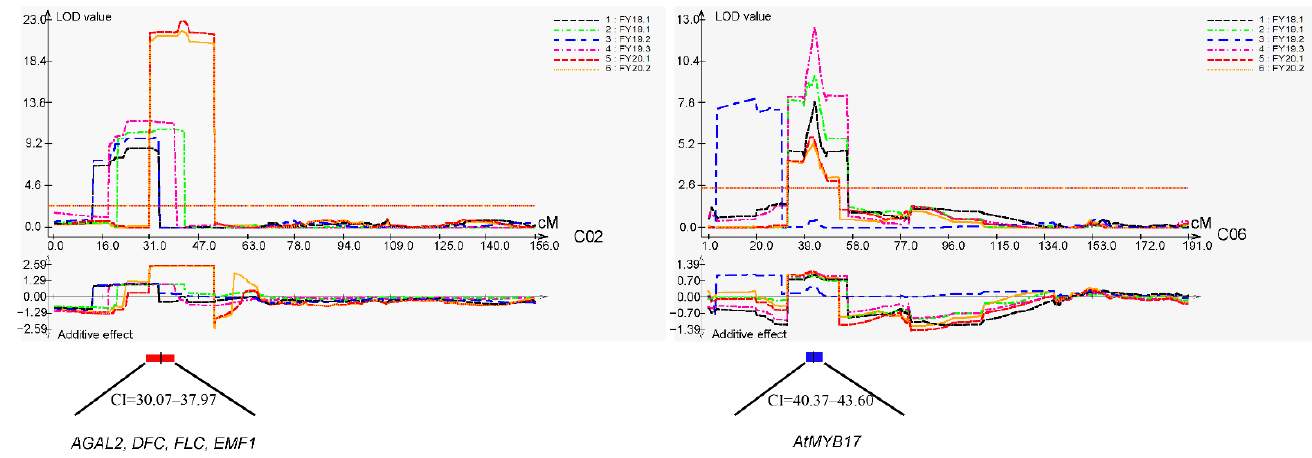
Figure 5. Two major QTL sites for flowering time, C02 and C06. The upper curve represents the QTLs identified in six replicates in the three environments, and the lower curve represents the additive effect of the QTLs with the same color. The major QTLs are shown under the confidence intervals. Candidate genes related to flowering time are shown under the major QTL.